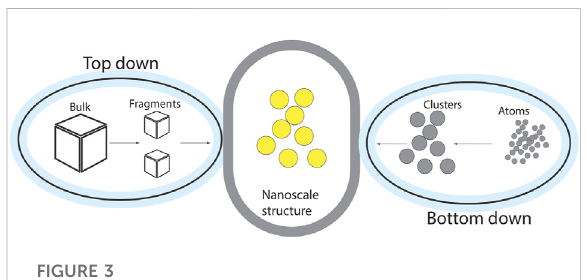
FIGURE 3 An overview of Top-down and bottom-up approaches.